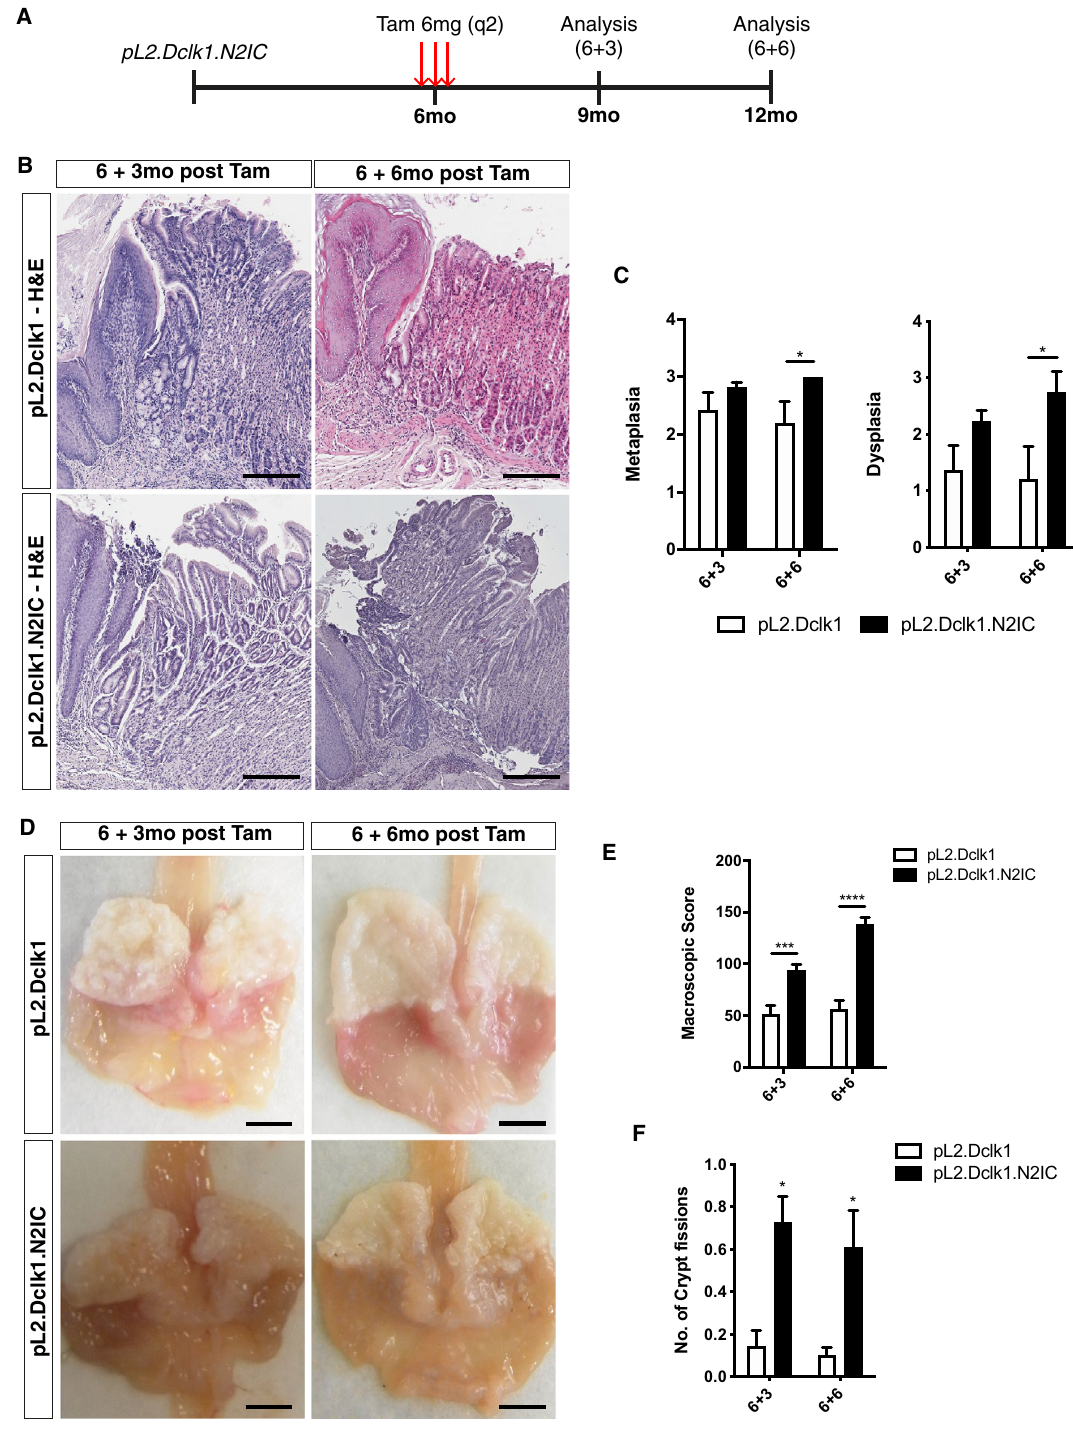
Figure 1. Notch activation in Dclk1-positive gastric tuft cells accelerates BE progression. ( A ) Experimental scheme illustrating timepoints of tamoxifen induction and tissue collection for analysis. ( B ) Representative H&E pictures of the SCJ of pL2.Dclk1 and pL2.Dclk1.N2IC mice, respectively; scale bars = 200 µm. ( C ) Histopathologic scoring in pL2. Dclk1.N2IC compared to pL2.Dclk1 controls for metaplasia (6 + 3 n = 23 pL2.Dclk1.N2IC, n = 7 pL2.Dclk1